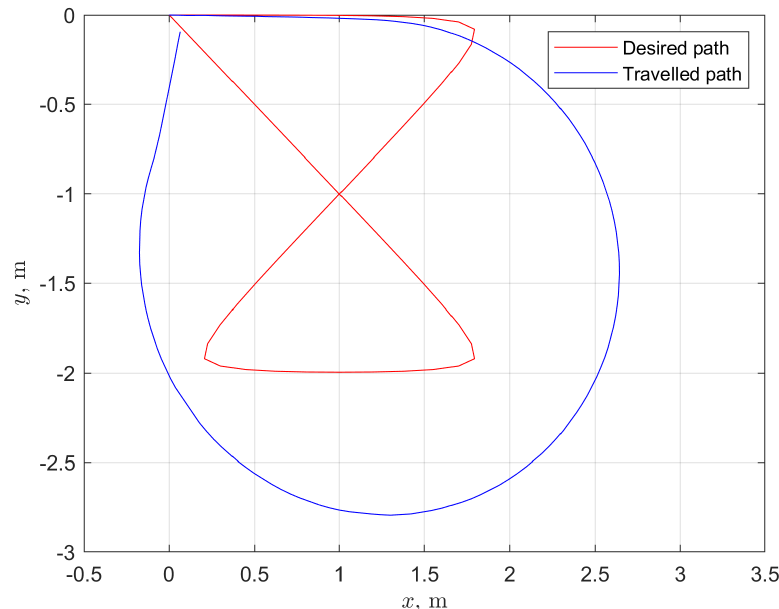
Figure 32. Desired path vs. actually traveled path for the highest value of the cost function equal to 1.3732—track